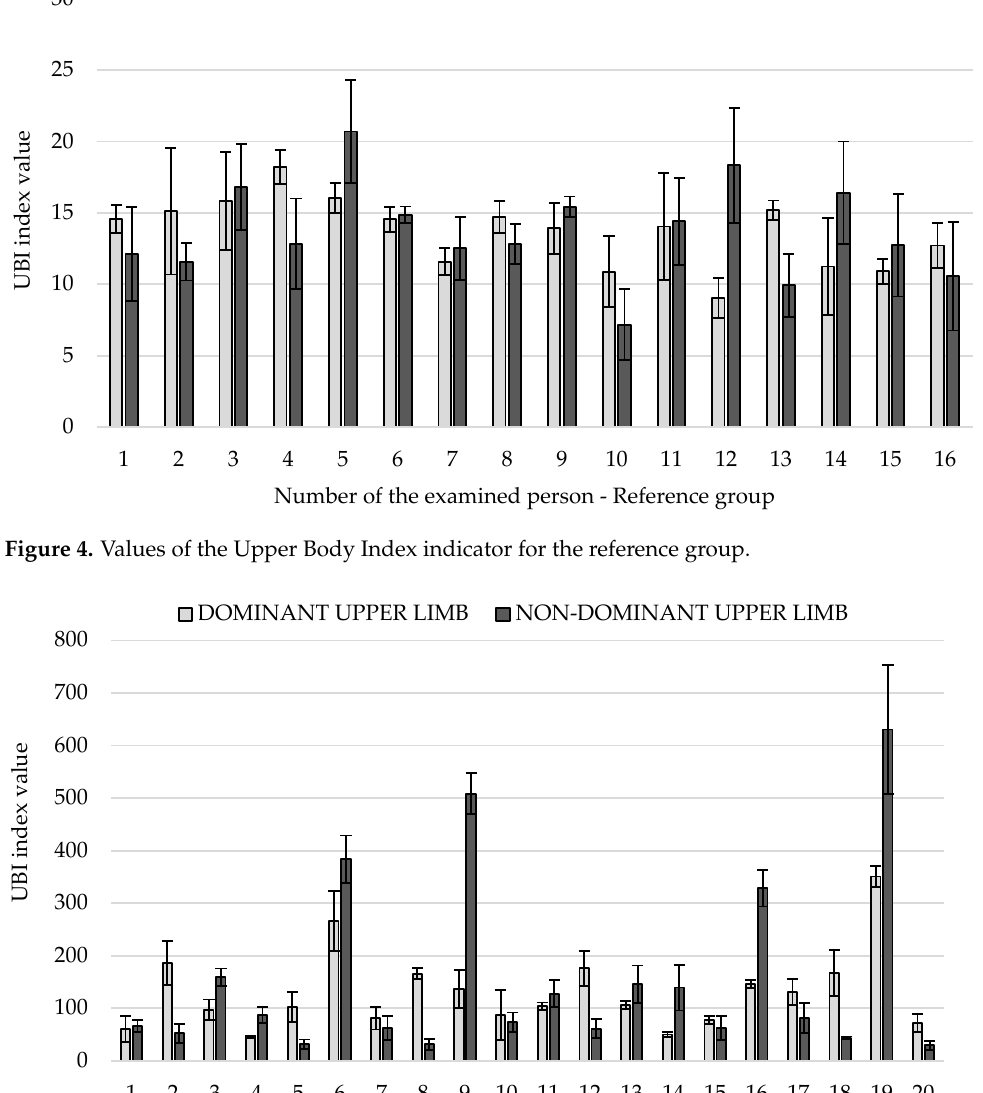
Table 9. Data obtained for the Upper Body Index indicator in the reference group.